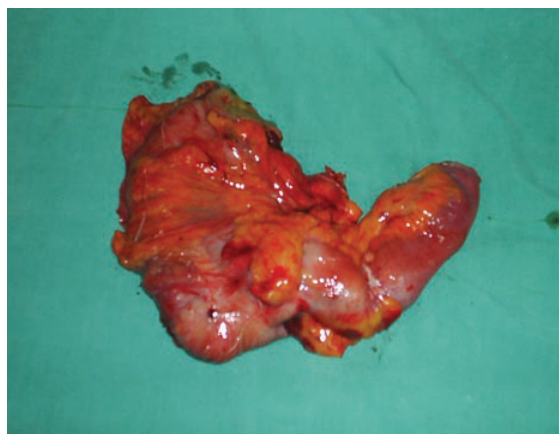
Figure 3. Ileal neuroendocrine tumor: viewed by videopill. Figure 4. Ileal neuroendocrine tumor: viewed by